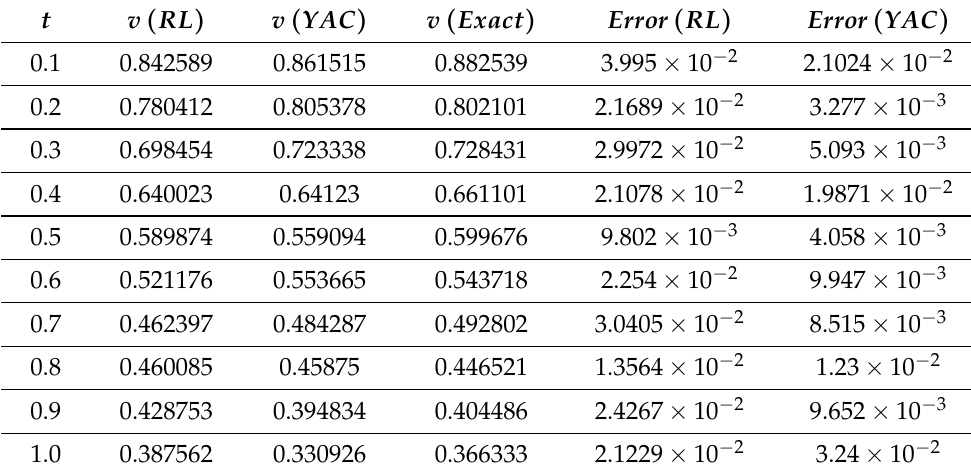
Table 3. Comaprison of α − HATM Solution in sense of YAC derivative operator, RL derivative operator and exact solution for Case